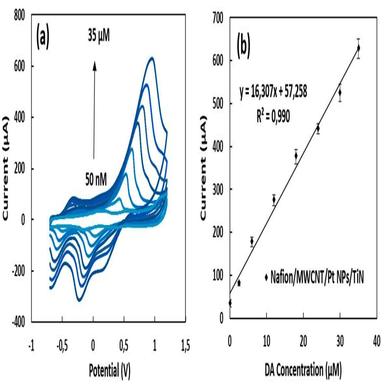
CVs of (a) Nafion/MWCNTs/Pt NPs/TiN electrode upon increasing the concentration of DA in PBS (50 mM, pH = 7.4) at scan rate of 50 mV/s. (b) Calibration curve obtained from CV voltammogram data for Nafion/MWCNTs/Pt NPs/TiN electrode in the range 50 nM–35 μM of DA.